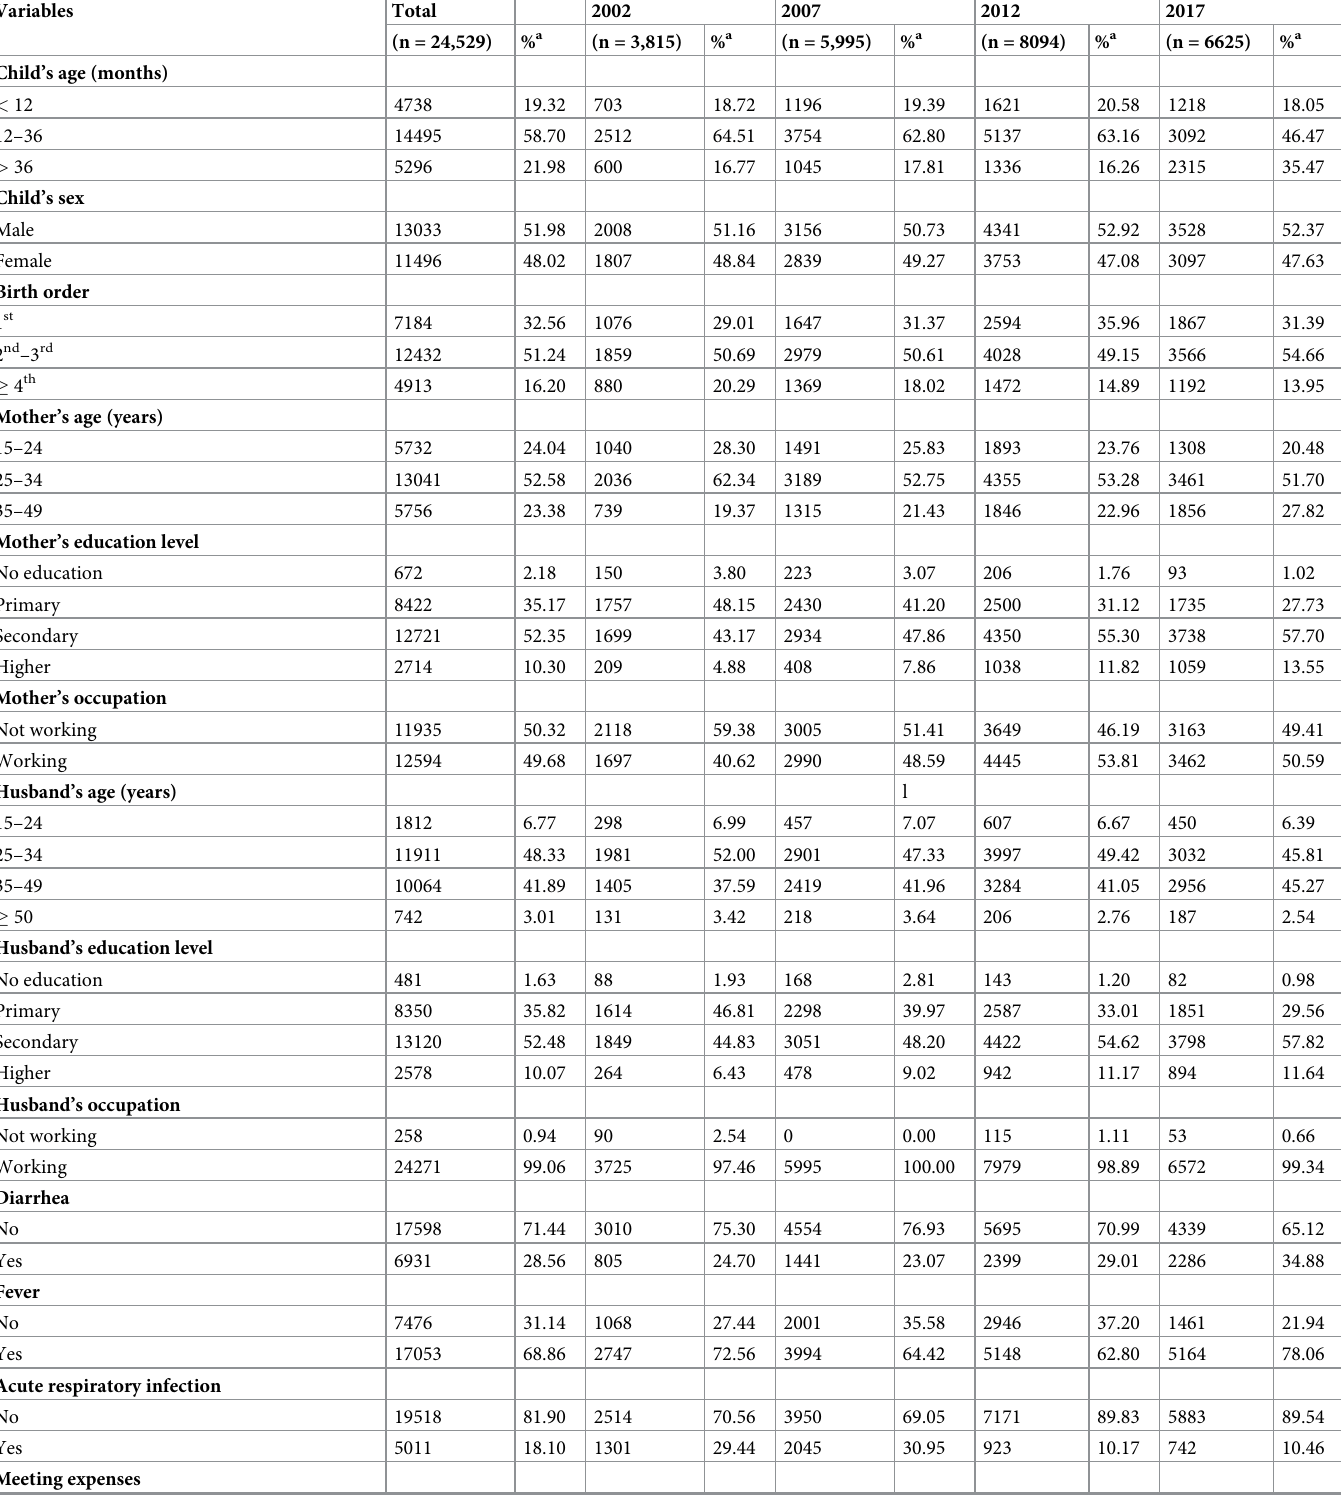
Table 1. Characteristics of mothers aged 15–49 years in Indonesia (n = 24,529; prepared by the authors from analysis of the data).